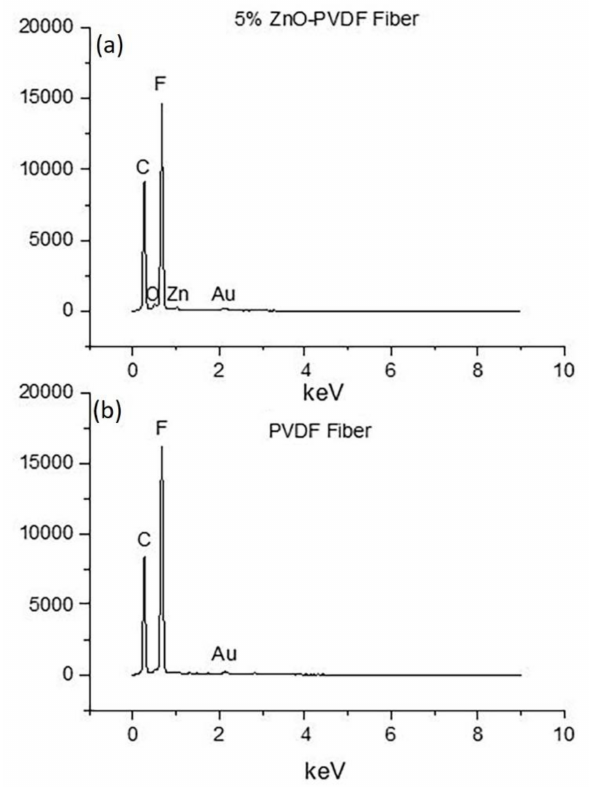
Figure 4. Energy Dispersive X-ray Spectroscopy (EDS) of ( a ) 5% ZnO-PVDF and ( b ) PVDF